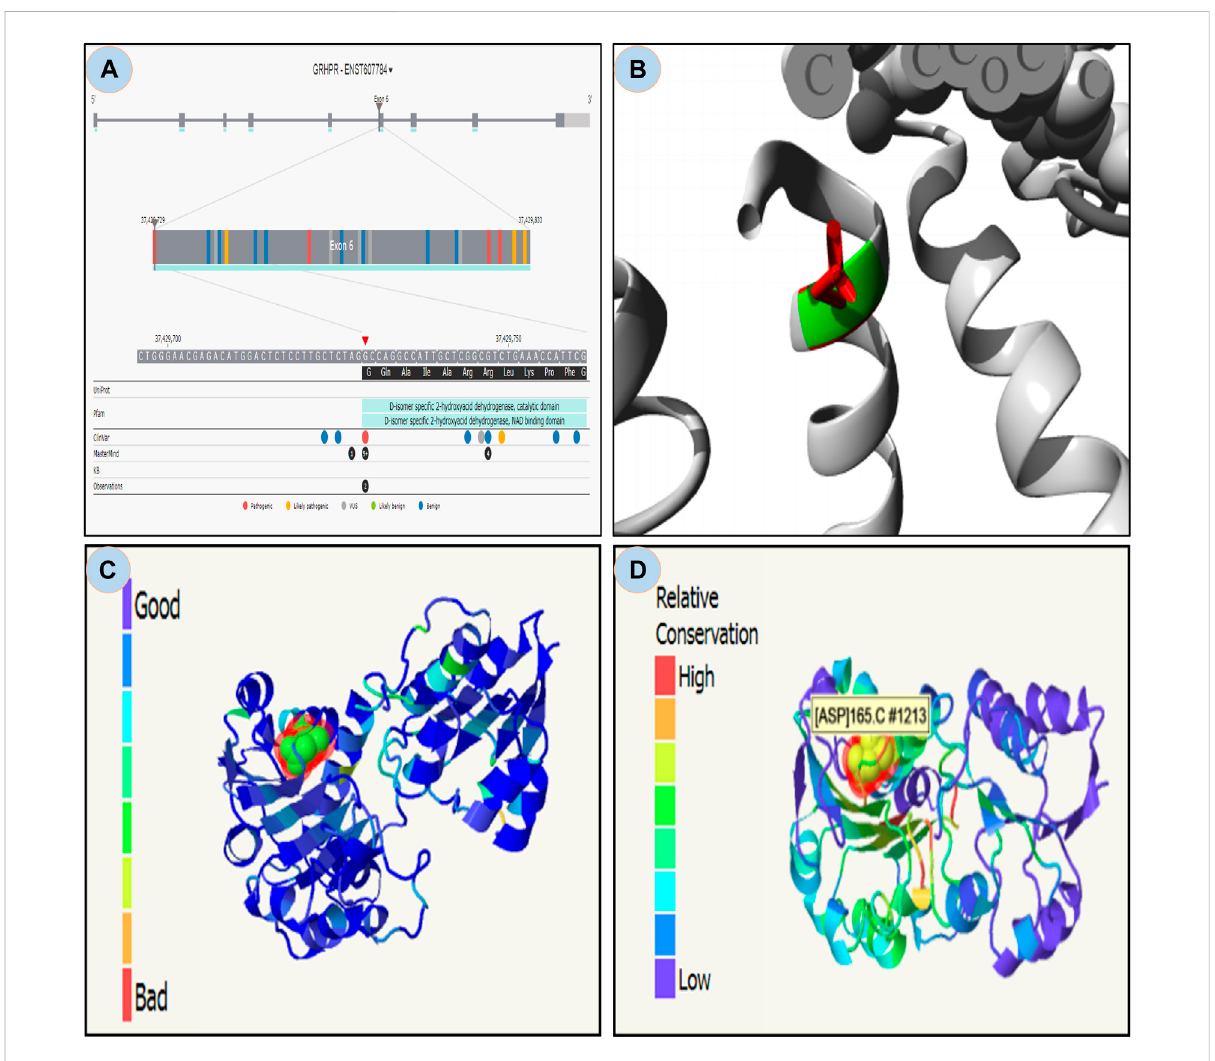
FIGURE 4 Moon diploid: (A) Showing mutation in the region of NAD binding domain; Hope: (B) Mutated residue (ASP) shown in red is large compared to wildresidueingreen; (C) Phyre:showingrelativelyhighclash(leftbarindicatesgradientofclash)inthemutatedregion;and (D) Showingrelativehigh conservation in the mutated